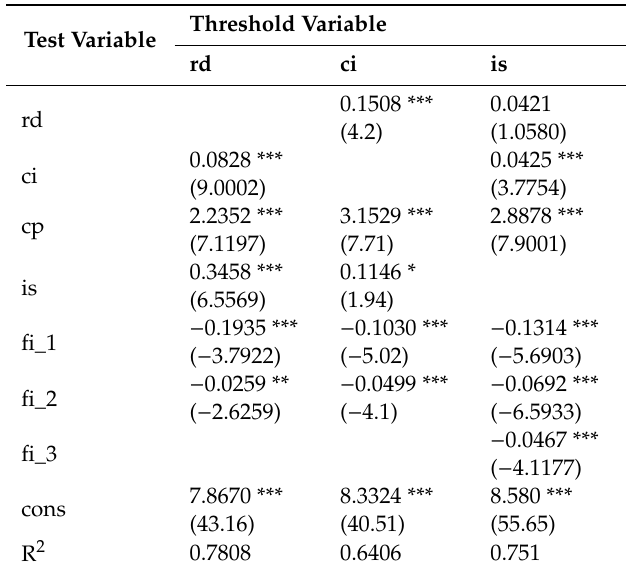
Table 8. Threshold model regression results for foreign investment and carbon